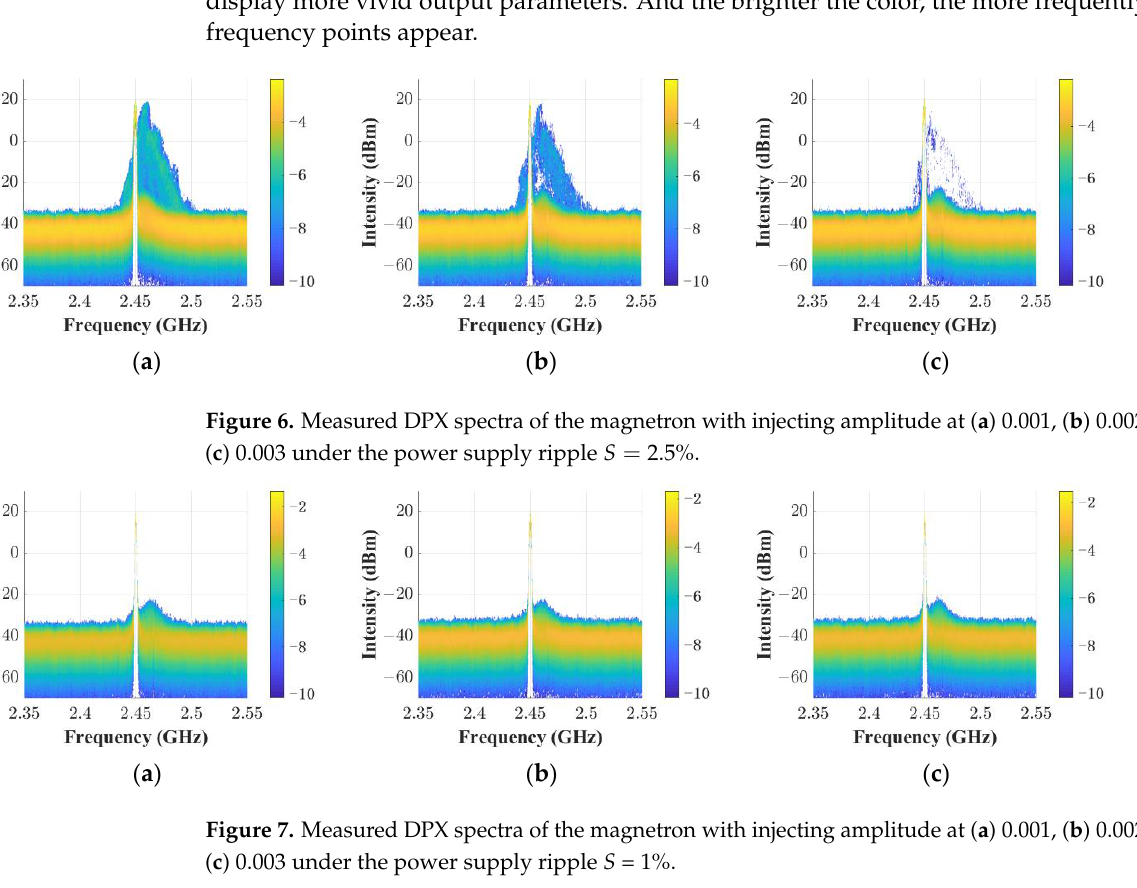
Figure 7. Measured DPX spectra of the magnetron with injecting amplitude at ( a ) 0.001, ( b ) 0.002 and ( c ) 0.003 under the power supply ripple S = 1%. 5. Conclusions The performance of injection-locked magnetron is jointly impacted by the power sup- ply ripple and the frequency pushing effect. In this paper, firstly, the equivalent circuit was adopted to obtain the expression of the locking bandwidth with respect to the power supply ripple 𝑆 and the frequency pushing effect 𝛼 , and the locking performance was obtained by the numerical simulation, which was an asymmetrical curve, different from the curve derived by the traditional Adler equation. With the increasing of the power sup- ply ripple 𝑆 , the locking bandwidth was reducing. Conversely, it was getting wider when the injection amplitude 𝜇 increased. Then, the experiments were set up to verify the